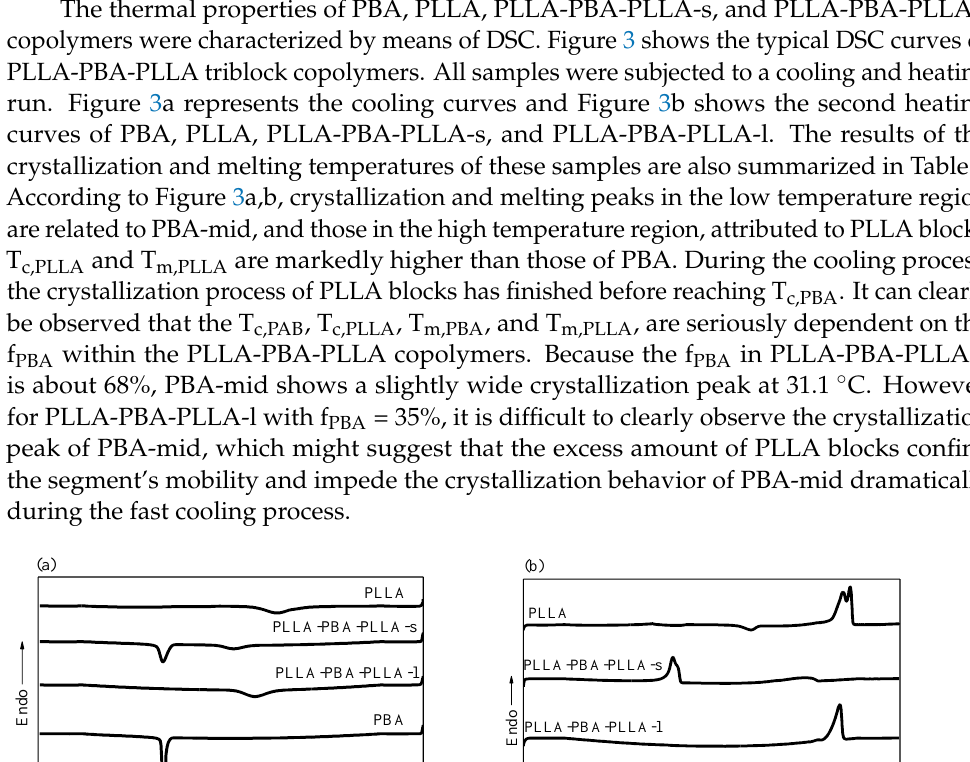
7 of 18 Figure 2. 1 HNMR spectra of ( a ) PBA and ( b ) PLLA-PBA-PLLA copolymers. As to the syntheses of PLLA-PBA-PLLA triblock copolymers, the ROP of L-lactide monomers was carried out in bulk with a prepared PBA prepolymer and SnOct 2 as the catalyst under 120 °C. It has been reported that less or no transesterification reactions oc- cur under such reaction conditions [29]. Figure 2b shows a typical 1 HNMR spectrum of